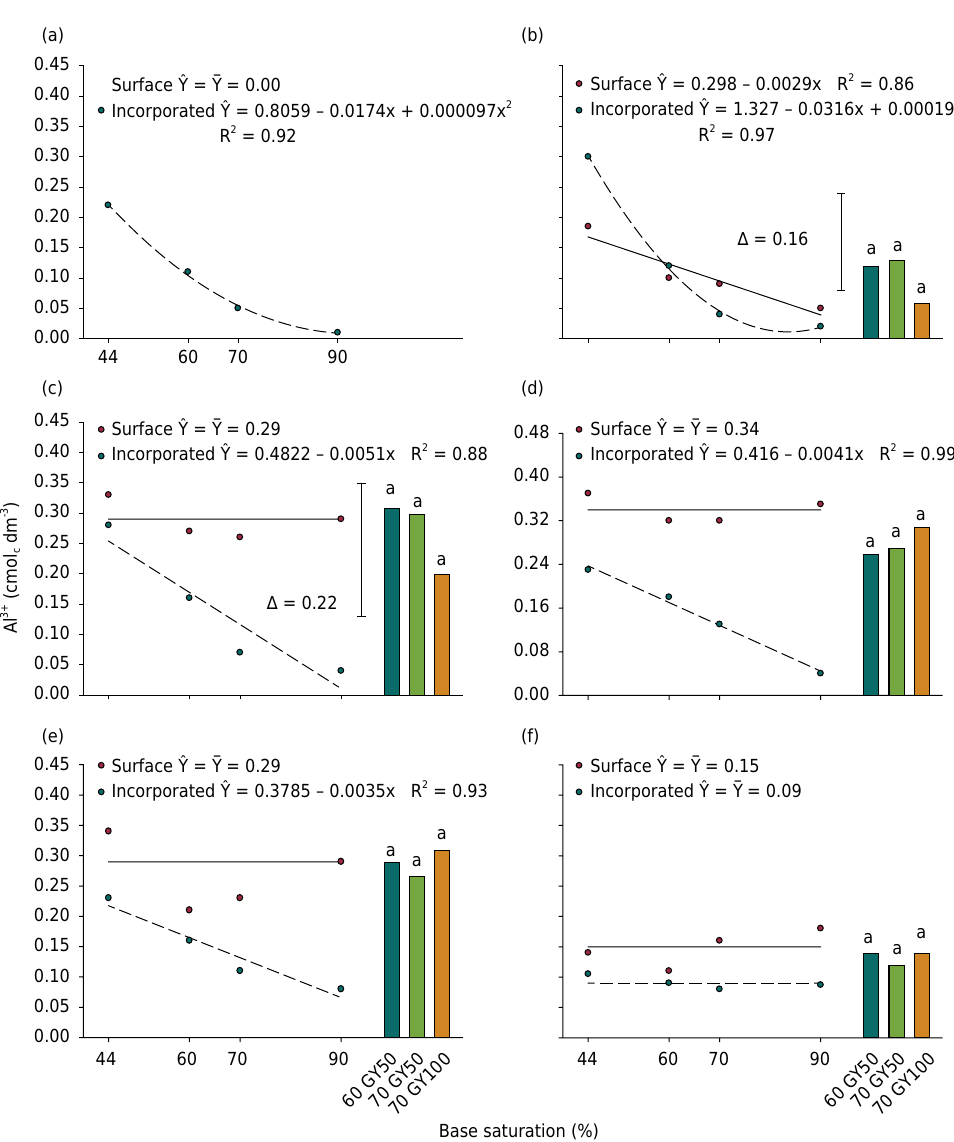
Figure 2. Exchangeable aluminum (Al 3+ ) after reapplication of lime and phosphogypsum at different layers (m): 0.00-0.05 (a), 0.05-0.10 (b), 0.10-0.20 (c), 0.20-0.30 (d), 0.30-0.40 (e), and 0.40-0.60 (f). Different letters above the bars indicate a significant difference between the treatments with phosphogypsum based on Tukey’s test (p<0.05). The vertical bar indicates the DMS between each factorial vs additional treatment based on a Dunnett test (p<0.05). An F test revealed a significant difference between the modes of lime application to the layers presented in figures 1a (p<0.00), 1b (p<0.00), 1c (p<0.09), and 1d